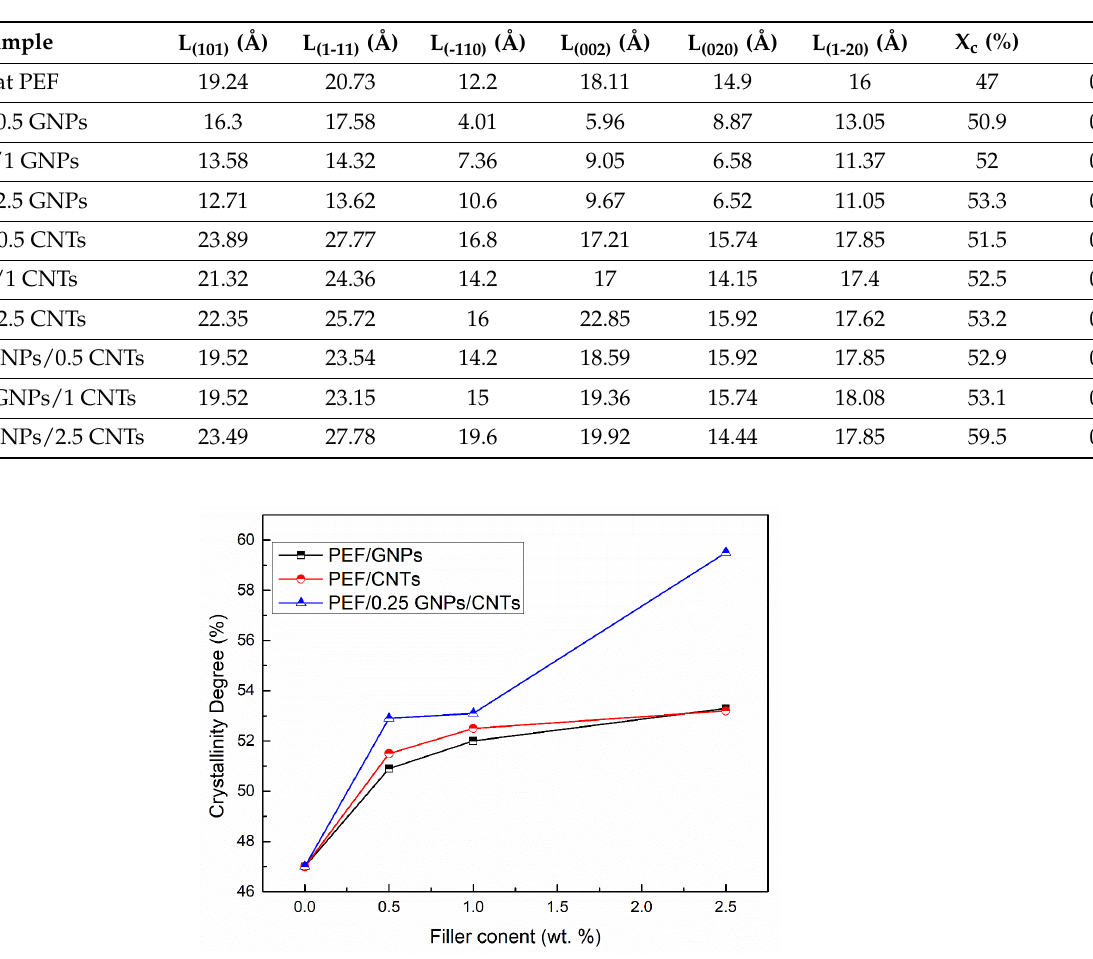
Figure 2. Crystallinity degree vs. filler content of PEF/GNPs, PEF/CNTs, and PEF/0.25 GNPs/CNTs nanocomposites.